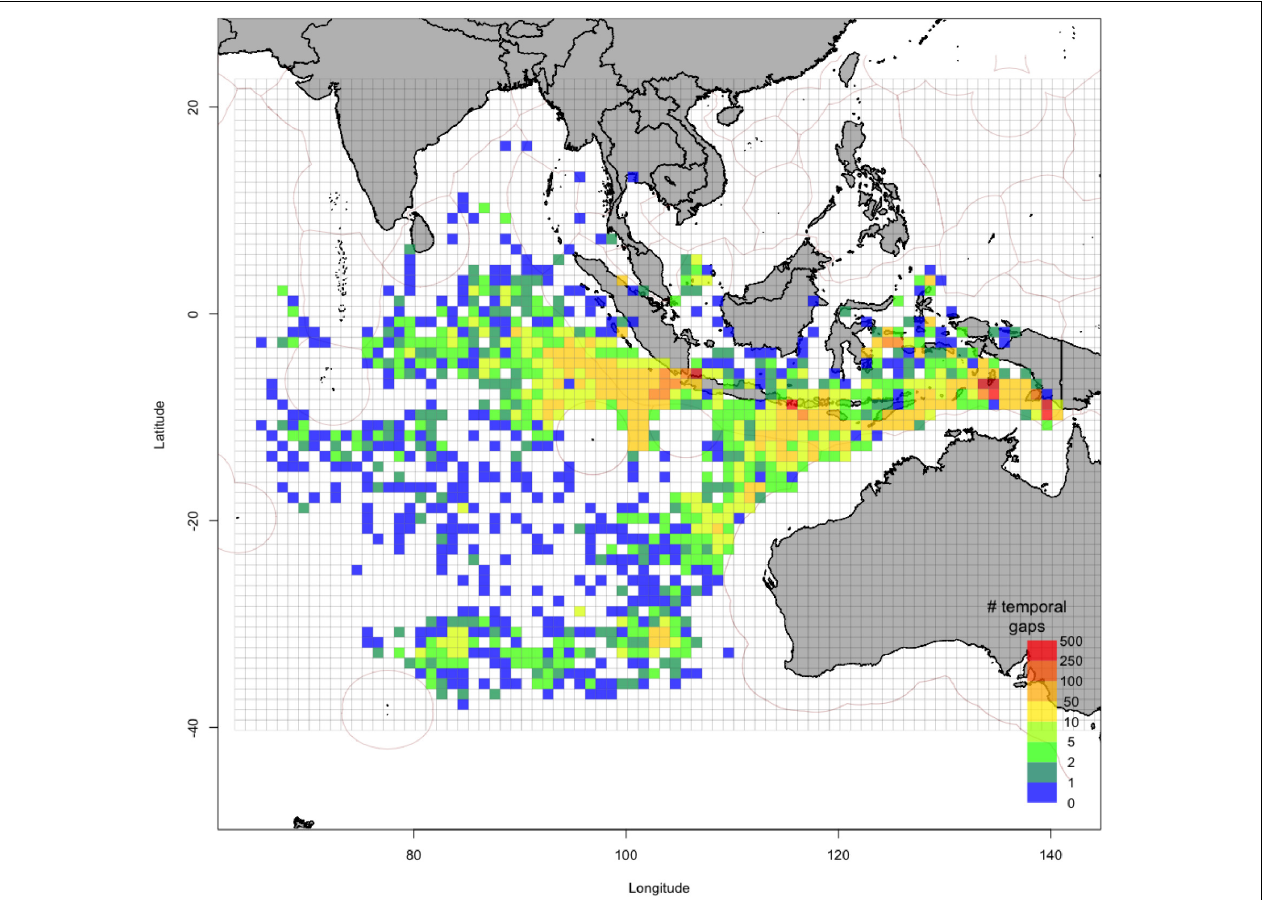
FIGURE 5 | Number of intermissions in VMS transmission per 0.5 degree grid cell across all longline vessels tracked in this study ( n = 1,082). Countries’ EEZs boundaries are represented by thin red